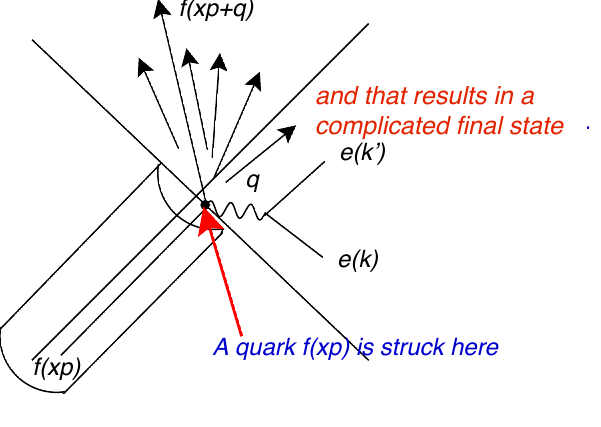
Figure 2: A typical event in deep-inelastic